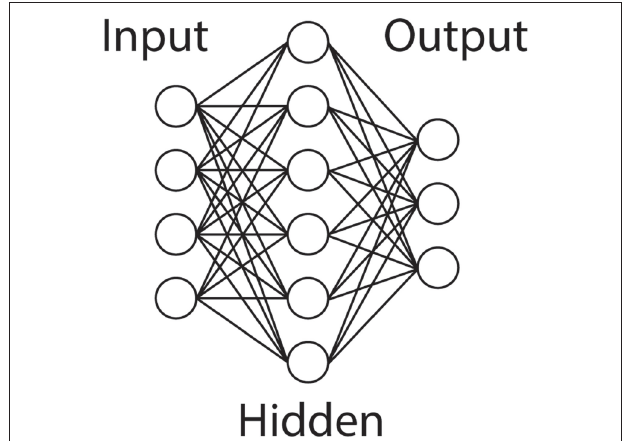
FIGURE 4 | Artificial Neural Network. An illustration of a typical ANN topology. An input layer projects to a single hidden layer, which connects to the output layer. Common variations include additional hidden layers and recurrent